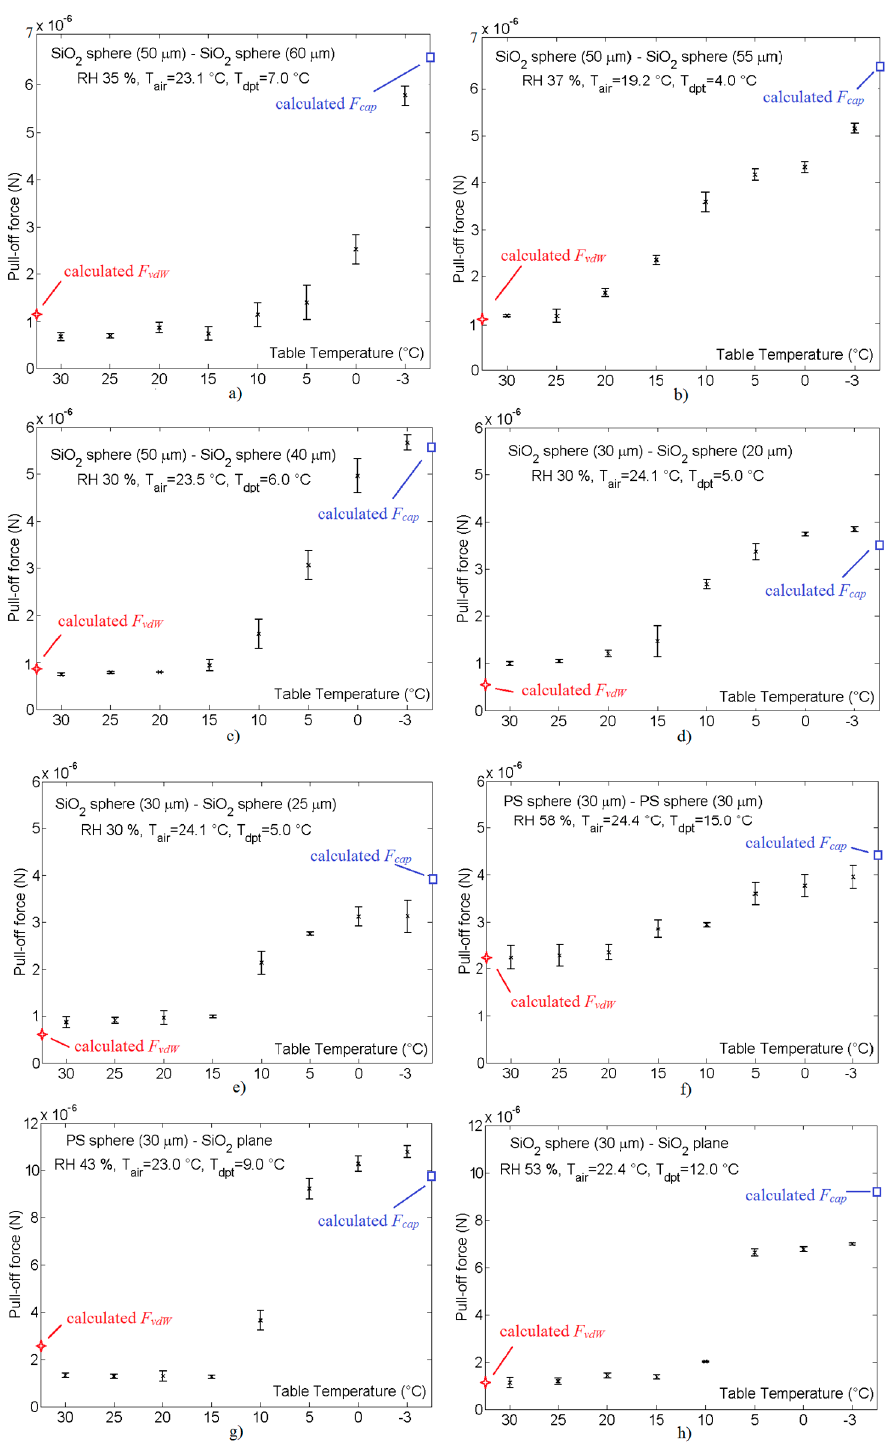
Figure 8. Measurements of the pull-off forces with their standard deviations vs. the table temperature between spherical micro-sized objects with different diameters, materials and humidity levels (RH): ( a ) SiO 2 sphere ( d = 50 µm)-SiO 2 sphere ( d = 60 µm); ( b ) SiO 2 sphere ( d = 50 µm)-SiO 2 sphere ( d = 55 µm); ( c ) SiO 2 sphere ( d = 50 µm)-SiO 2 sphere ( d = 40 µm); ( d ) SiO 2 sphere ( d = 30 µm)-SiO 2 sphere ( d = 20 µm); ( e ) SiO 2 sphere ( d = 30 µm)-SiO 2 sphere ( d = 25 µm); ( f ) Polystyrene sphere ( d = 30 µm)-Polystyrene sphere ( d = 30 µm); ( g ) Polystyrene sphere ( d = 30 µm)-SiO 2 plane; ( h ) SiO 2 sphere ( d = 30 µm)-SiO 2 plane. (Remark: The sizes of the spheres are their diameters. The temperature is measured approximately 6 mm away from the place where the micro-sized object and the tip of the gripper touch each other, so the actual temperature of the object and the tip of the gripper may differ by 2–3 °C).